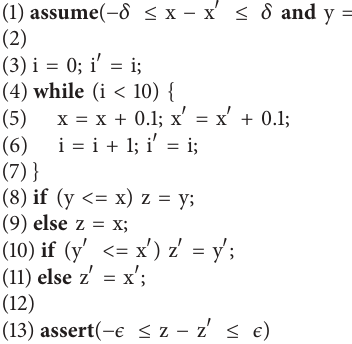
Figure 3: Self-composition of the piecewise linear program for robustness analysis.